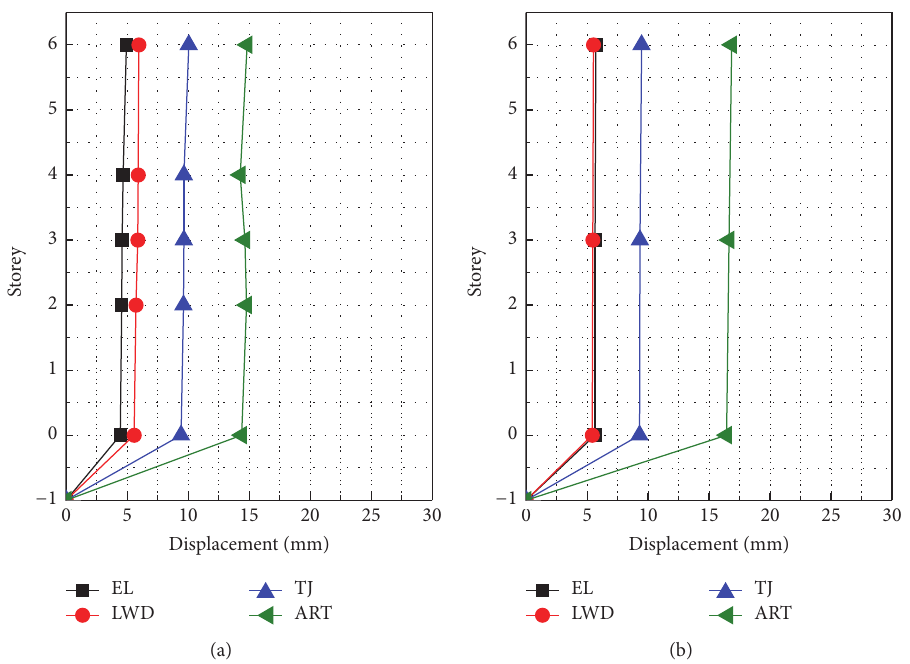
Figure 23: Profiles of maximum storey displacements of isolated structure under major earthquakes: (a) direction x ; (b) direction y .